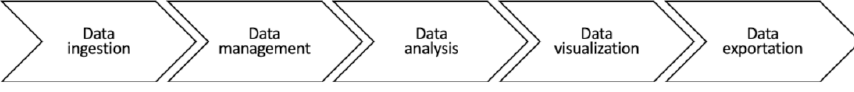
Figure 1. Deepint.net architecture